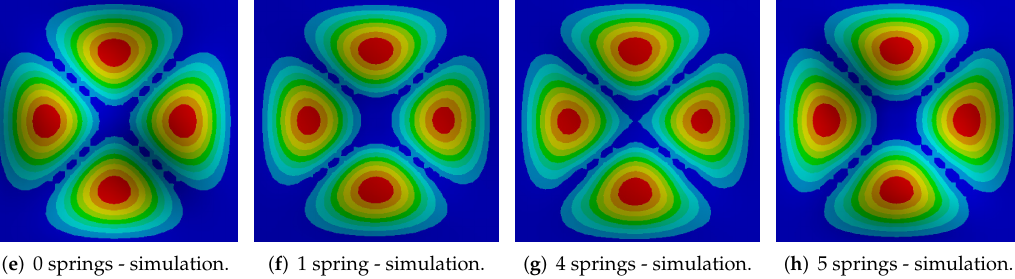
Figure 7. Experimental results for ON/OFF control algorithm compared with ANSYS simulations.